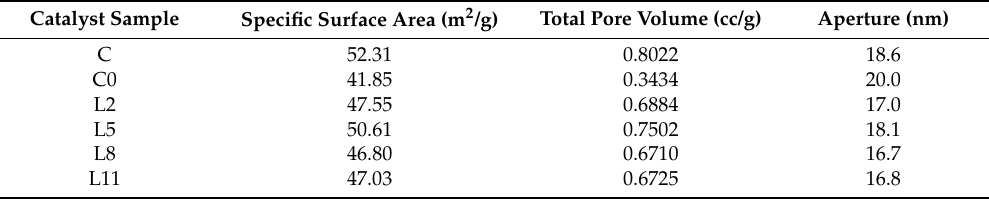
Table 3. Structural characteristics of catalysts before and after activation.